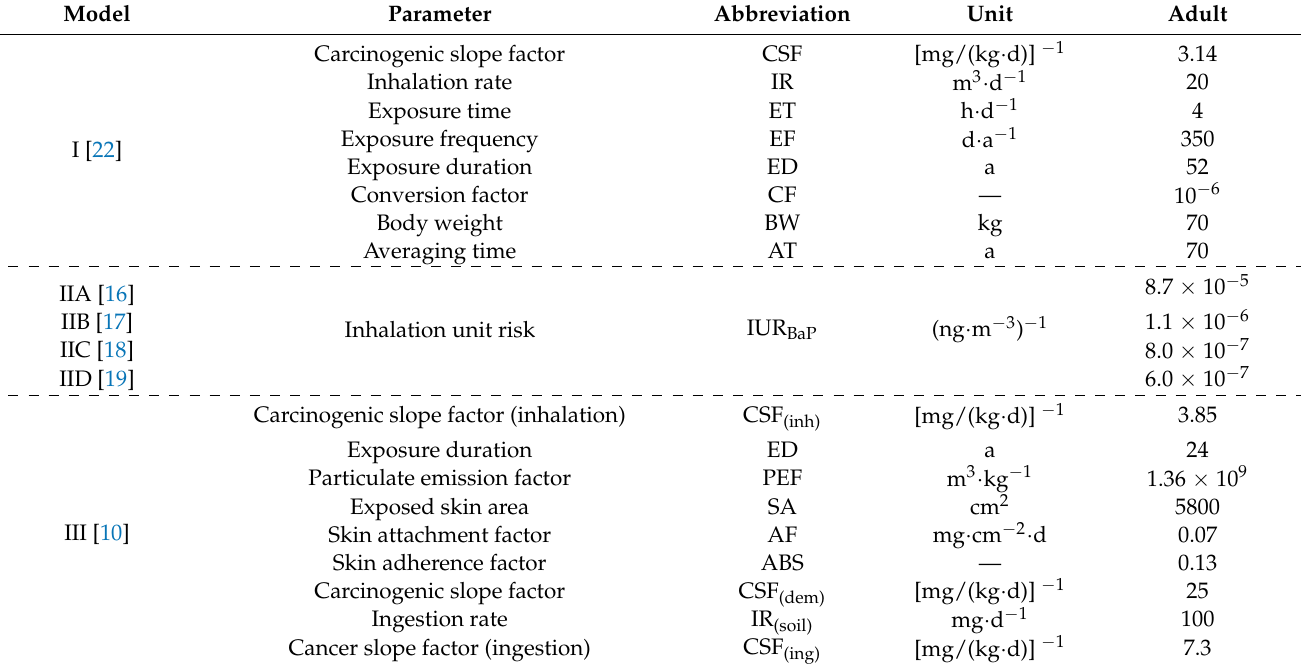
Table 1. Exposure parameters and their values in models of assessed carcinogenic